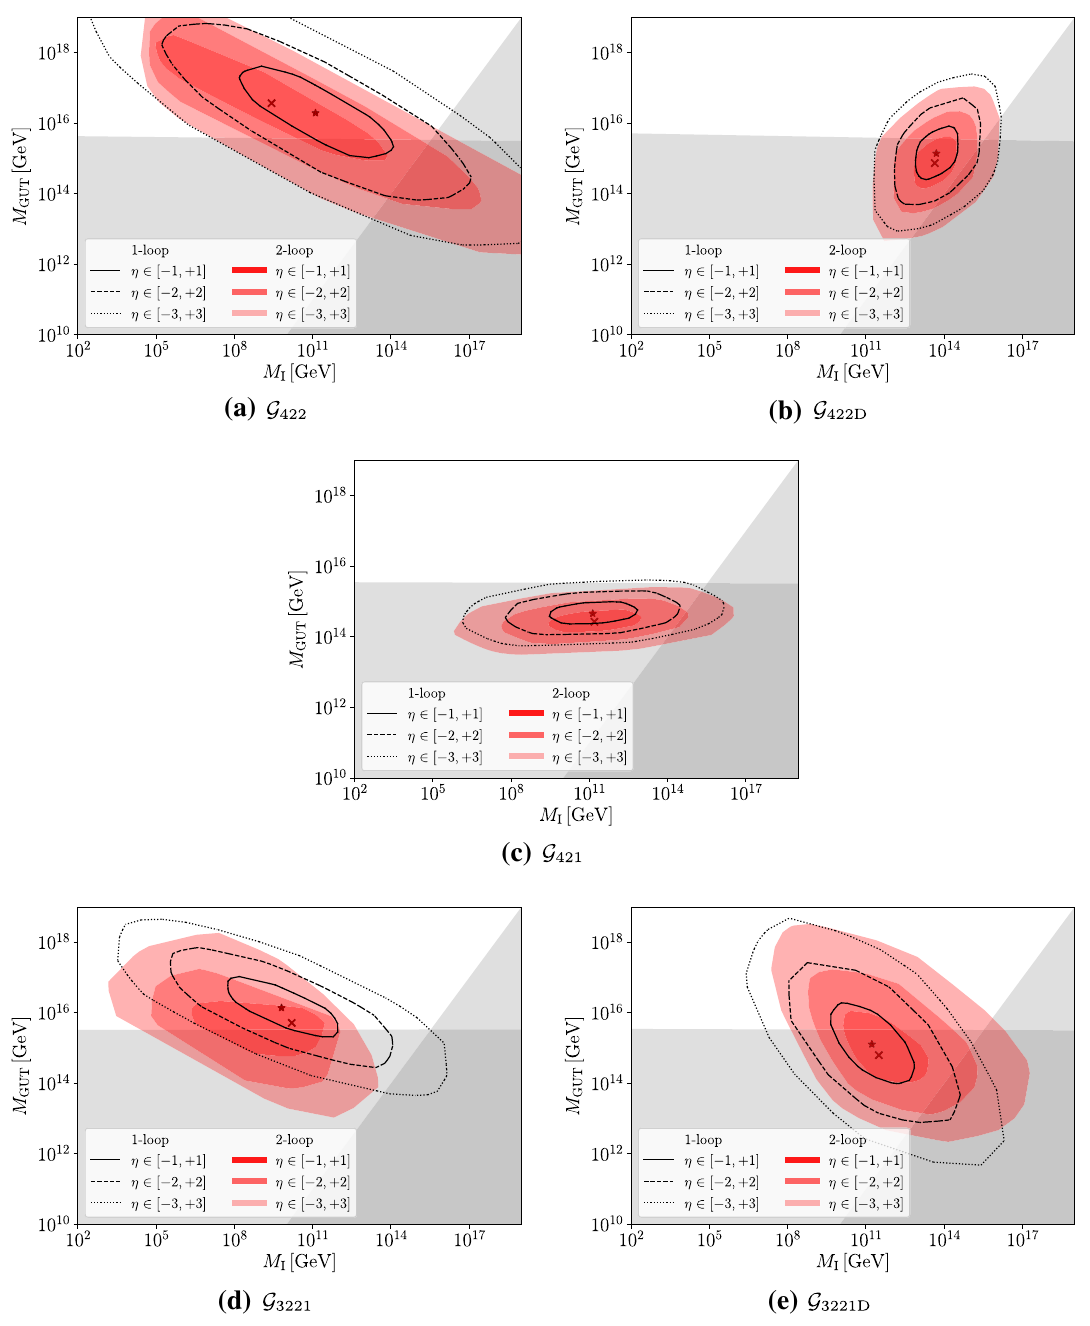
Fig. 3 Variations in the scales due to threshold corrections for the models which achieve gauge coupling unification. The red shaded regions show the results with RG running at two-loop level, while the full, dashed, and dotted contours show the results at one-loop level. Concentric regions show the scales for the thresholds in the range